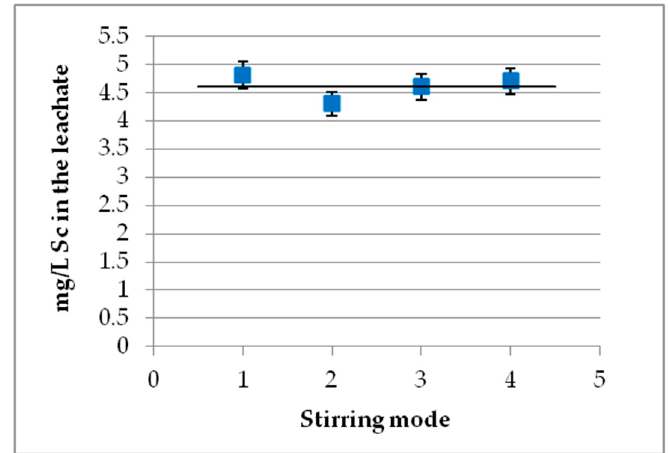
Figure 6. Effect of stirring mode (S/L 10%, 1 M H 2 SO 4 , t = 60 min). 1. Magnetic stirring at 650 rpm; 2. mechanical agitation at 550 rpm; 3. mechanical agitation at 650 rpm; 4, mechanical agitation with air at 550